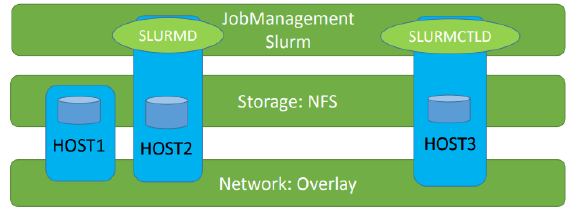
Figure 1. Schematics of the solution of three layers of the whole system are shown.